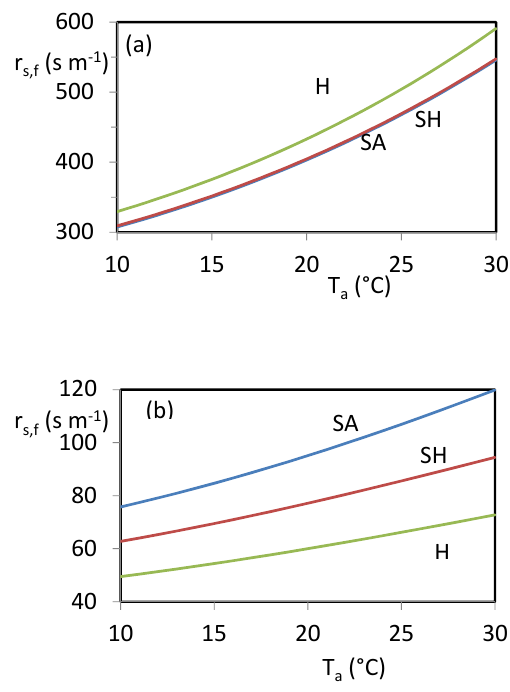
Figure 5. Variation of foliage surface resistance ( r s, f ) inferred from the basal crop coefficient ( K cb ) as a function of air temper- ature ( T a ) for the three climatic environments (SA: semi-arid; SH: sub-humid; H : humid) described in Table 1 with u a = 2m s − 1 , R a = 35MJm − 2 d − 1 and K e = 0.1: (a) initial stage, z h = 0.5m, K cb = 0.5; (b) mid-season stage, z h = 1.5m, K cb =